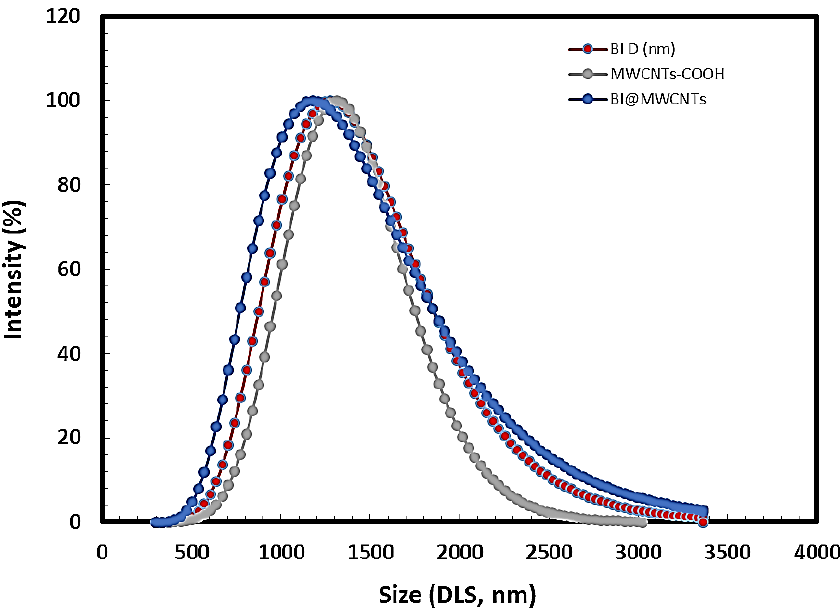
Figure 5. Size distribution by intensity obtained with DLS.